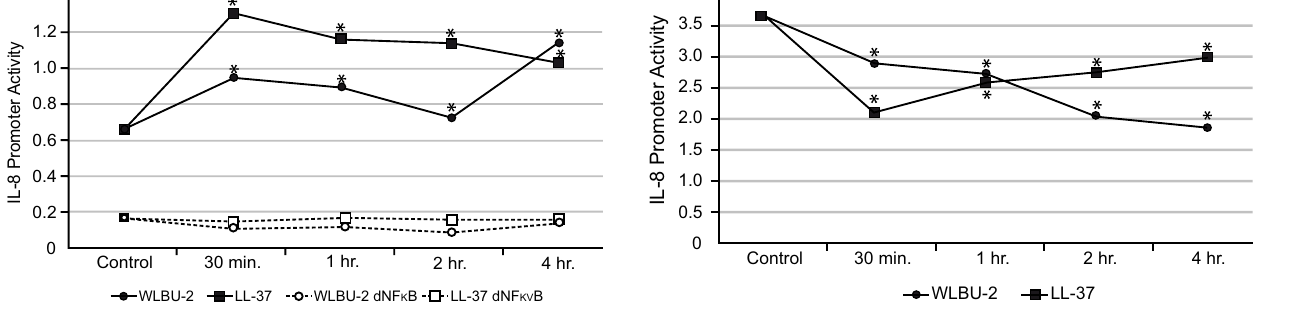
Figure 1. WLBU-2 increases IL-8 promoter activity in CF IB3-1 cells. CF IB3-1 ( Δ F508/W1282X) cells transiently transfected with a 5’ firefly luciferase gene flanking a 200bp wild type- (solid lines) or NF κ B mutant-IL-8 promoter (dashed lines) were treated with 25µM WLBU-2 (solid circles) or 25µM LL-37 (solid squares) followed by measurement of IL-8 promoter activity at time points ranging from 30min-4h by Dual-Luciferase Reporter assay. There was a significant increase in IL-8 promoter activity in cells exposed to either peptide compared to control (asterisks, p <0.005). In cells lacking the NF κ B site (dashed lines) , there was little IL-8 promoter activity, suggesting that both WLBU-2 (open circles) and LL-37 (open squares) may influence IL-8 secretion through the NF κ B pathway.